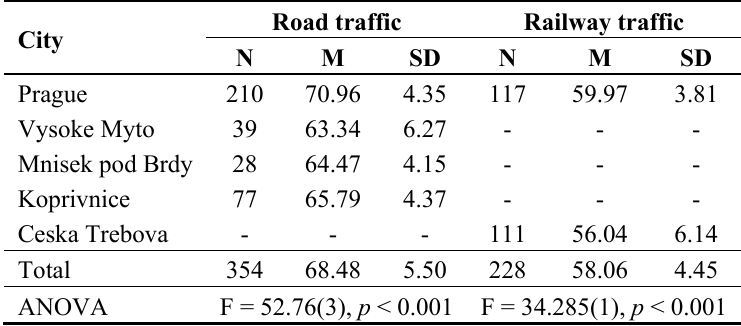
) in samples from different cities (means, standard deviations den